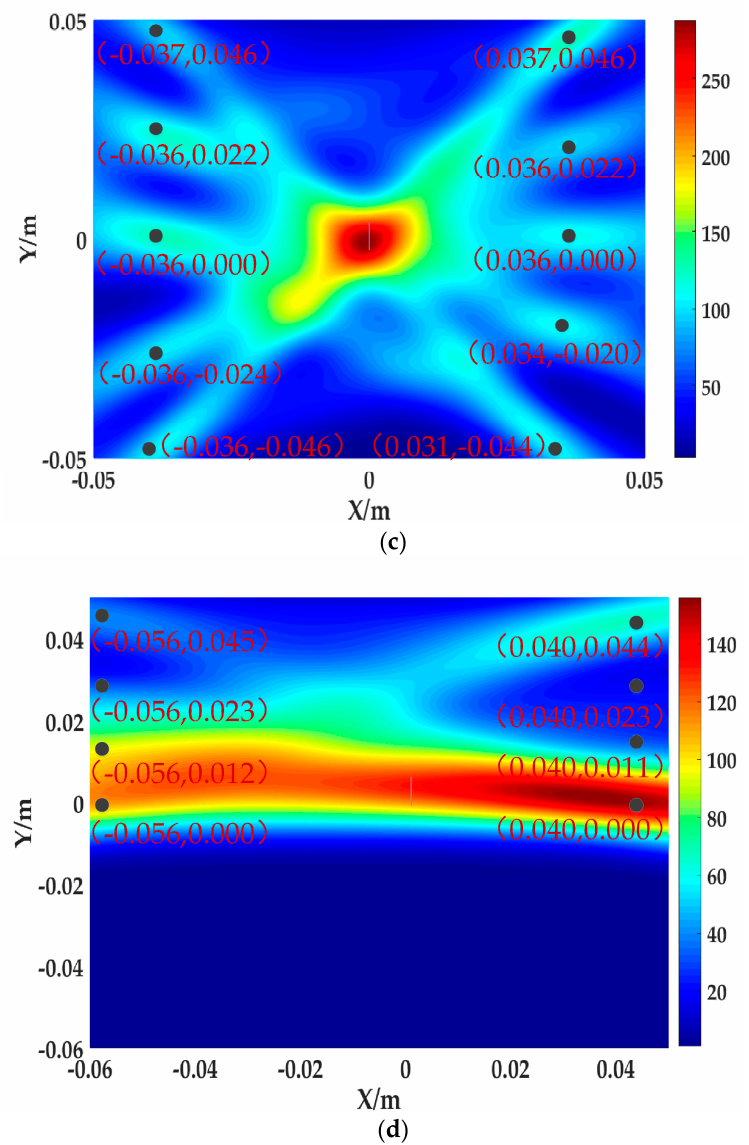
Figure 9. Positioning results when microcracks are in different positions in the scanning area: ( a ) microcrack in the lower right corner; ( b ) microcrack in the right side; ( c ) microcrack in the middle; ( d ) microcrack at the bottom.